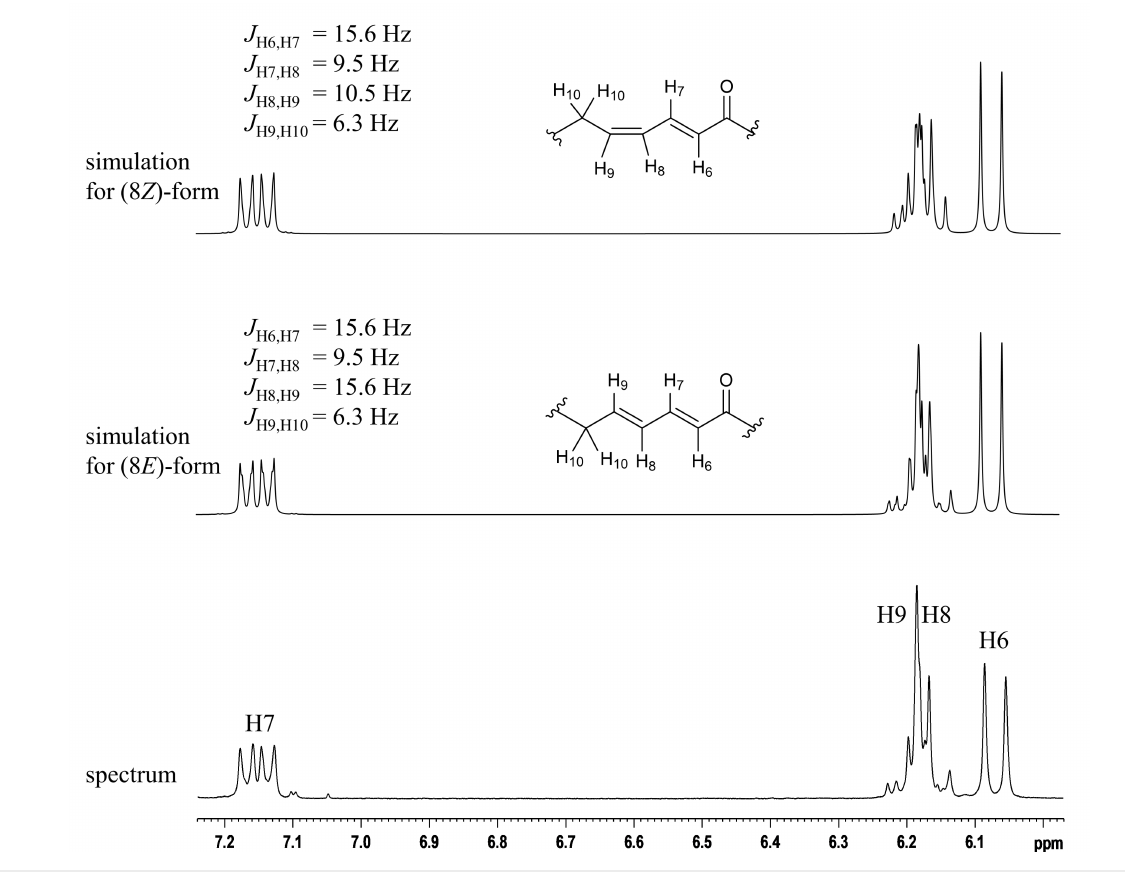
Figure 3: Spin system simulation for the C8–C9 double bond of 2 .